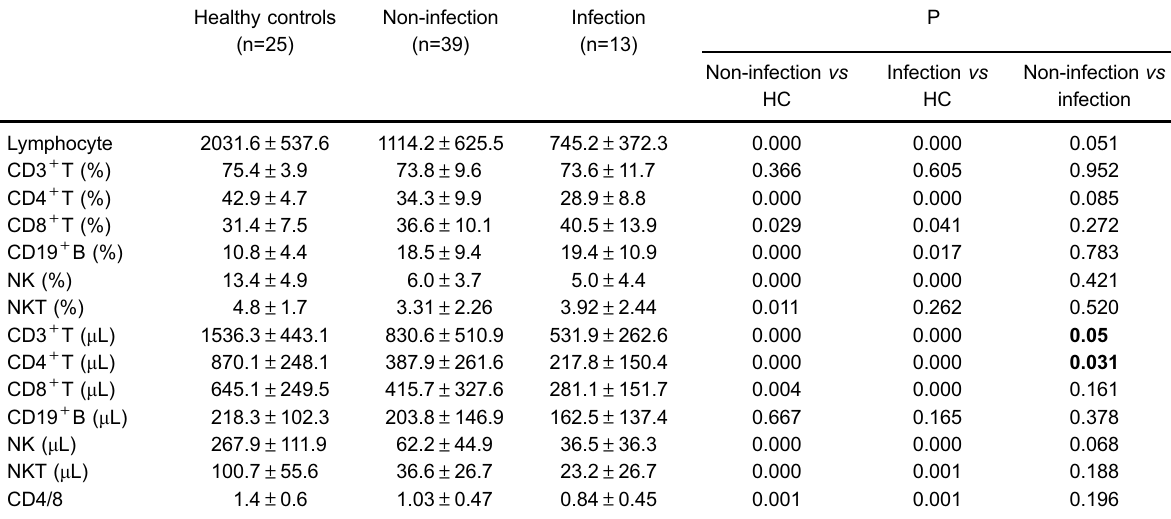
Table 2. Distribution of lymphocyte subsets in untreated systemic lupus erythematosus (SLE) patients with and without infection. Healthy